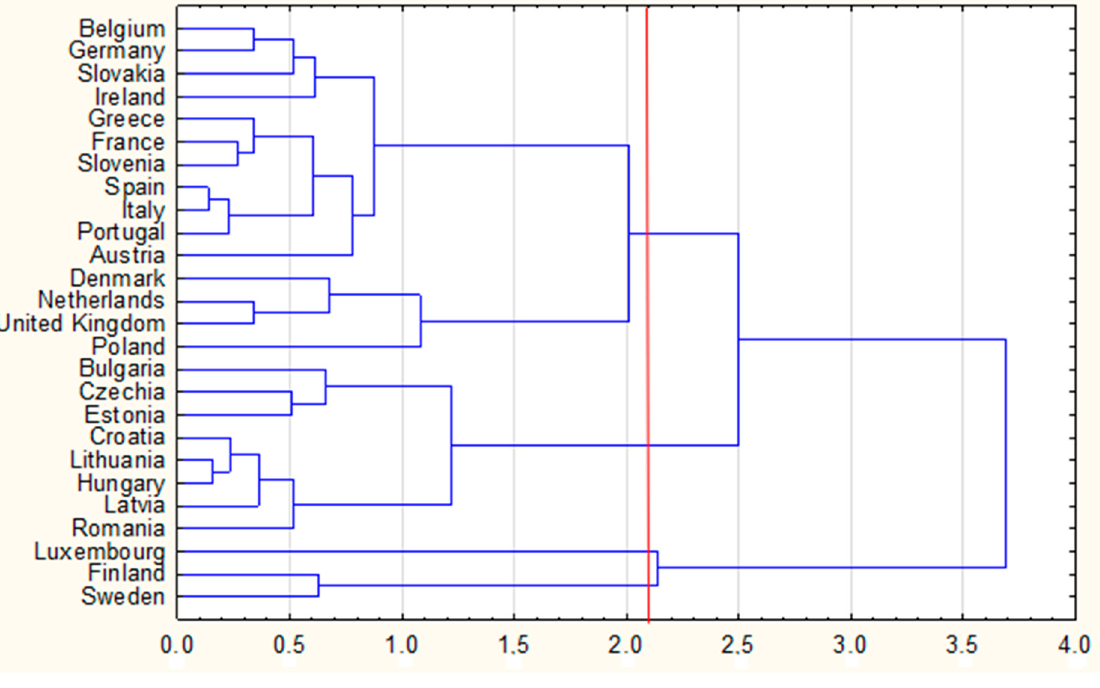
Figure 5. Dendrogram for 2010 using the Ward method.